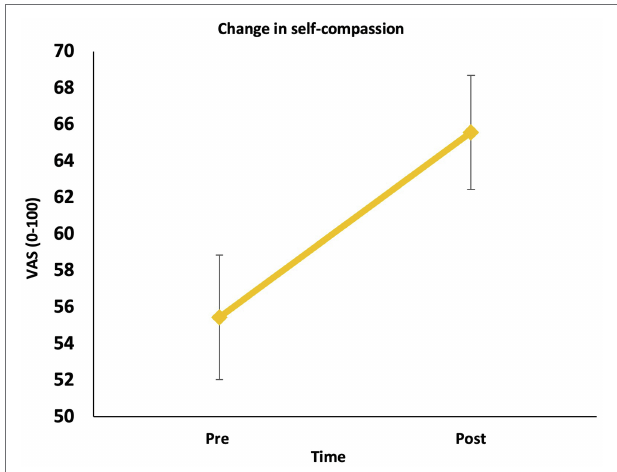
FIGURE 1 | Change in state self-compassion (pre to post).